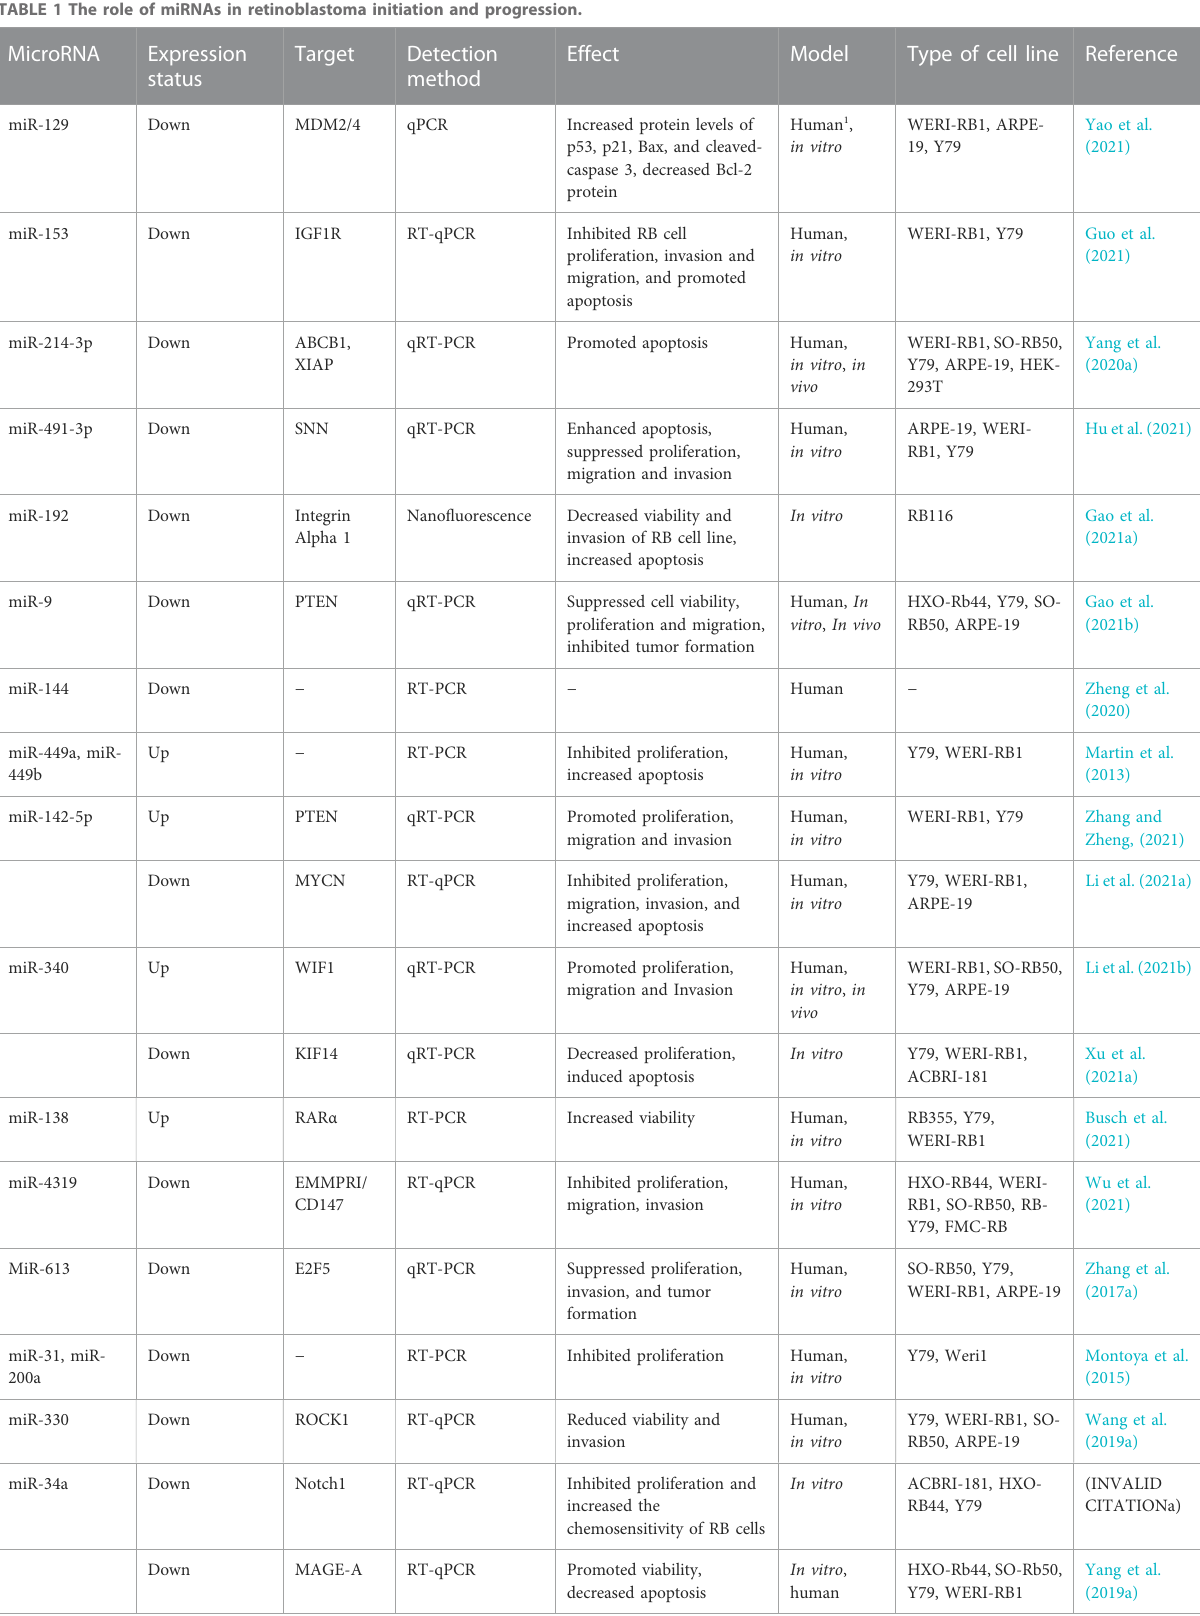
TABLE 1 The role of miRNAs in retinoblastoma initiation and